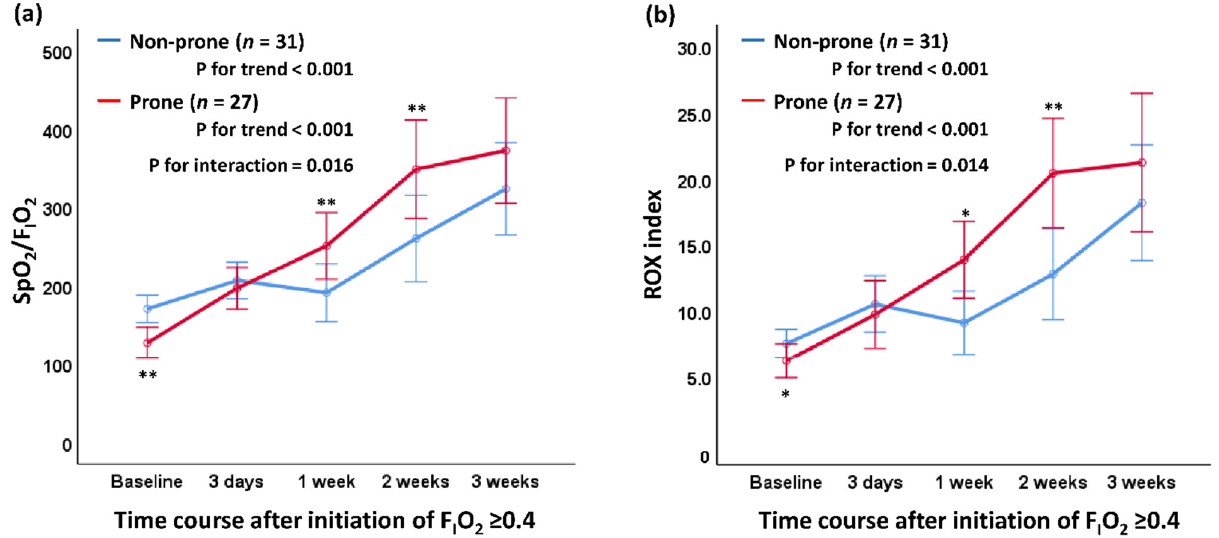
Figure 2. SpO 2 /F I O 2 and ROX index after initiation of F I O 2 ≥ 0.4 between the two groups based on prone therapy. ( a ) changes in SpO2/FIO2 and ( b ) changes in ROX index; red line, prone group; blue line, non-prone group. Data are estimated mean and 95% confidence interval. F I O 2 , fraction of inspired oxygen. *, p < 0.05 of inter-group comparison. **, p < 0.01 of inter-group comparison.